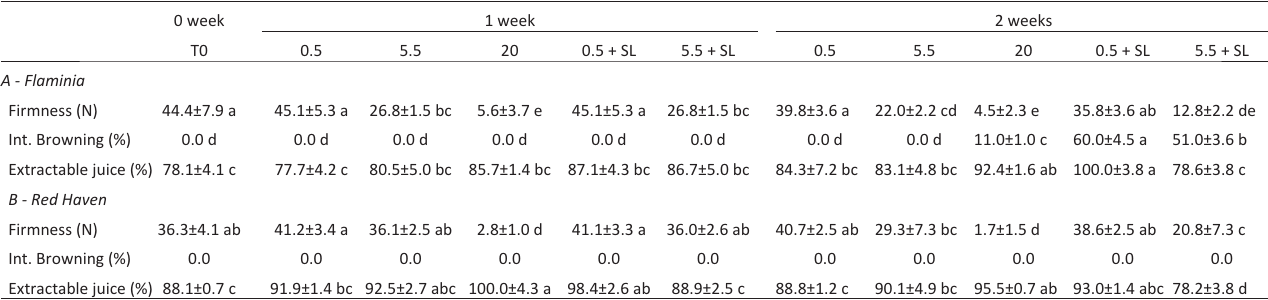
‘Flaminia’ (A) and ‘Red Haven’ (B) were analysed at harvest (0), at the end of 1 and 2 weeks of cold storage at 0.5 and 5.5°C, and after three additional days of shelf life (0.5 and 5.5°C + SL). Samples kept at 20°C represent the room temperature control. The average values of nine replicates ± SD for each treatment and measured parameter are reported. Letters indicate the results of Tukey's Honest Significant Difference (HSD) post hoc test, performed independently for each